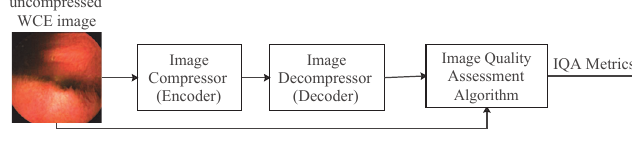
Fig. 1. Block diagram of a full-reference objective image quality assessment method for compressed WCE